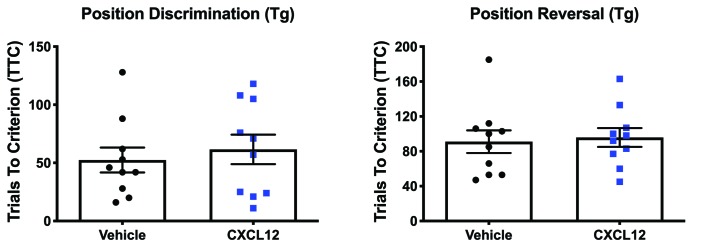
Vehicle and CXCL12-treated HIV-Tg rats performed similarly during position discrimination and position reversal.